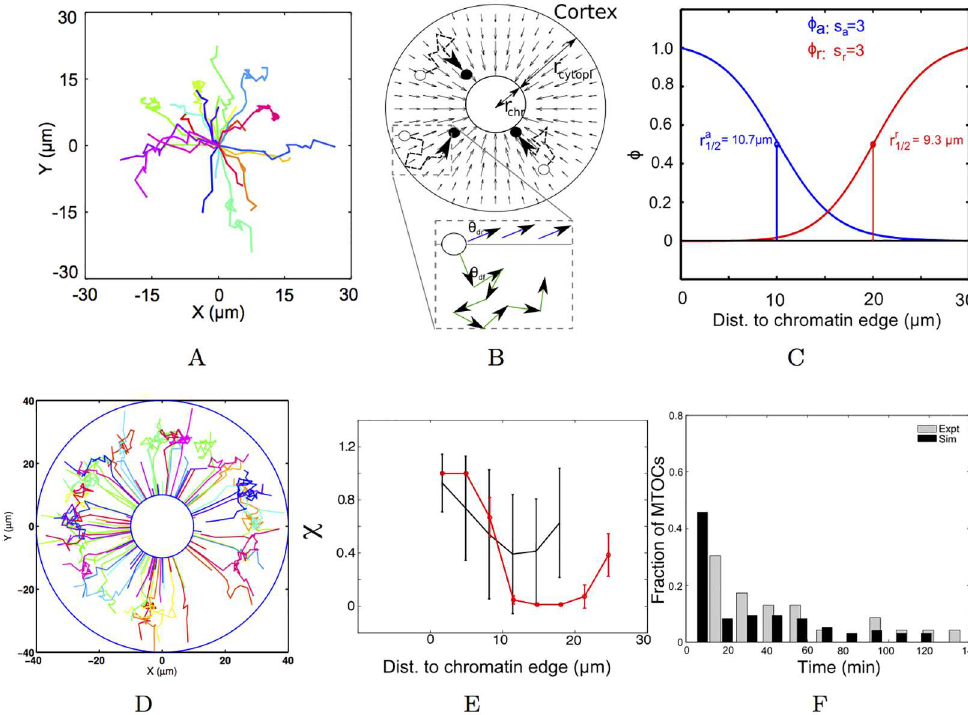
Fig 1. Optimizing the random walk with drift (RWD) gradient to experiment. (A) The experimentally measured2D trajectories of MTOCs from mouse oocytes (from previous work [9], replotted based on raw data provided by the authors) are modeled by (B) a 2D RWD model with the concentric cytoplasmic and chromatin regionsof radius r cyto and r chr respectively. The cytoplasmic motility of MTOCs from their initial positions(open circle) to final positions(closed circle) is driven by a field of drift (small arrows). (inset) The direction of motion is determined by the Brownian ( θ df ) and directed ( θ dr ) components. (C) The functional forms of the fields of ð ~ X Þ (blue) and repulsion, (cid:30) ð ~ X Þ (red), as a function of radial distance to chromatin (r) is determinedby attraction, (cid:30) a r the respective r 1/2 and s values. The optimizedgradient results in (D) XY trajectories from simulation(colors indicate individualtracks), (E) directionality ( χ ) (mean ± s.d.) as a function of radial distance from simulation(red) comparedto experiment (black) and (F) the frequency distribution of capture time ( t c ) from simulation (black) comparedto experiment (grey).